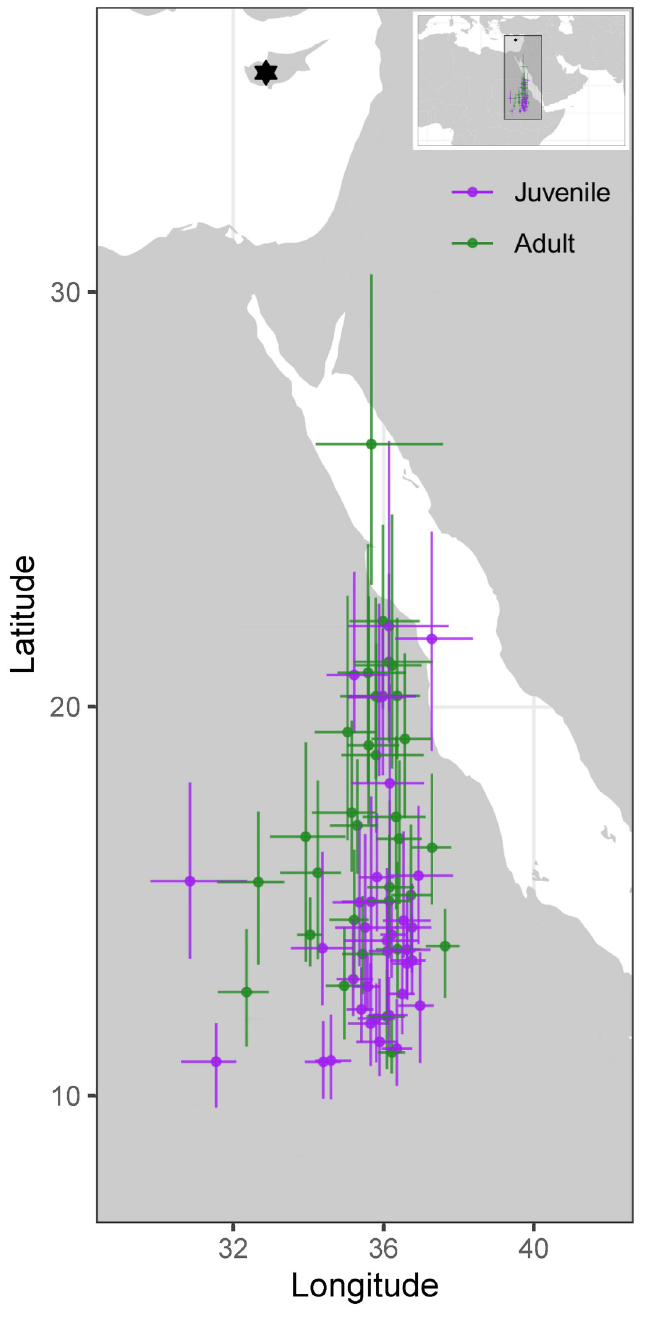
Fig 3. Non-breeding locations of adult and juvenile Cyprus wheatear. Locations are median location during December-January. Error bars show inter-quartile range. The black star shows location of the breeding ground field site in Troodos,